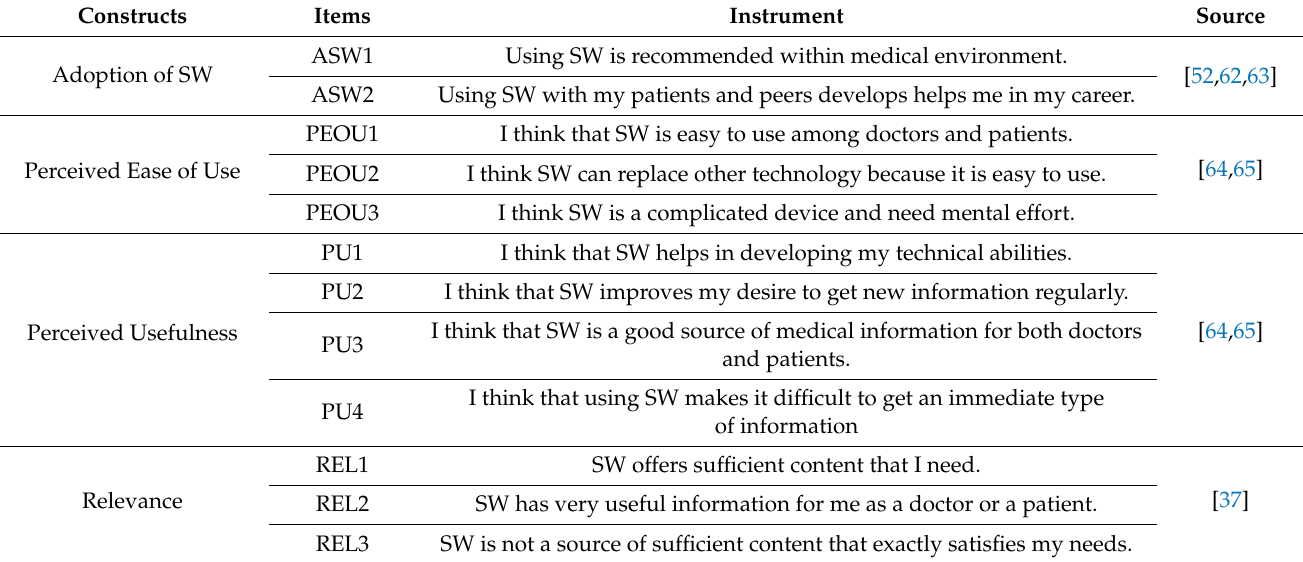
Table 3. Constructs and their